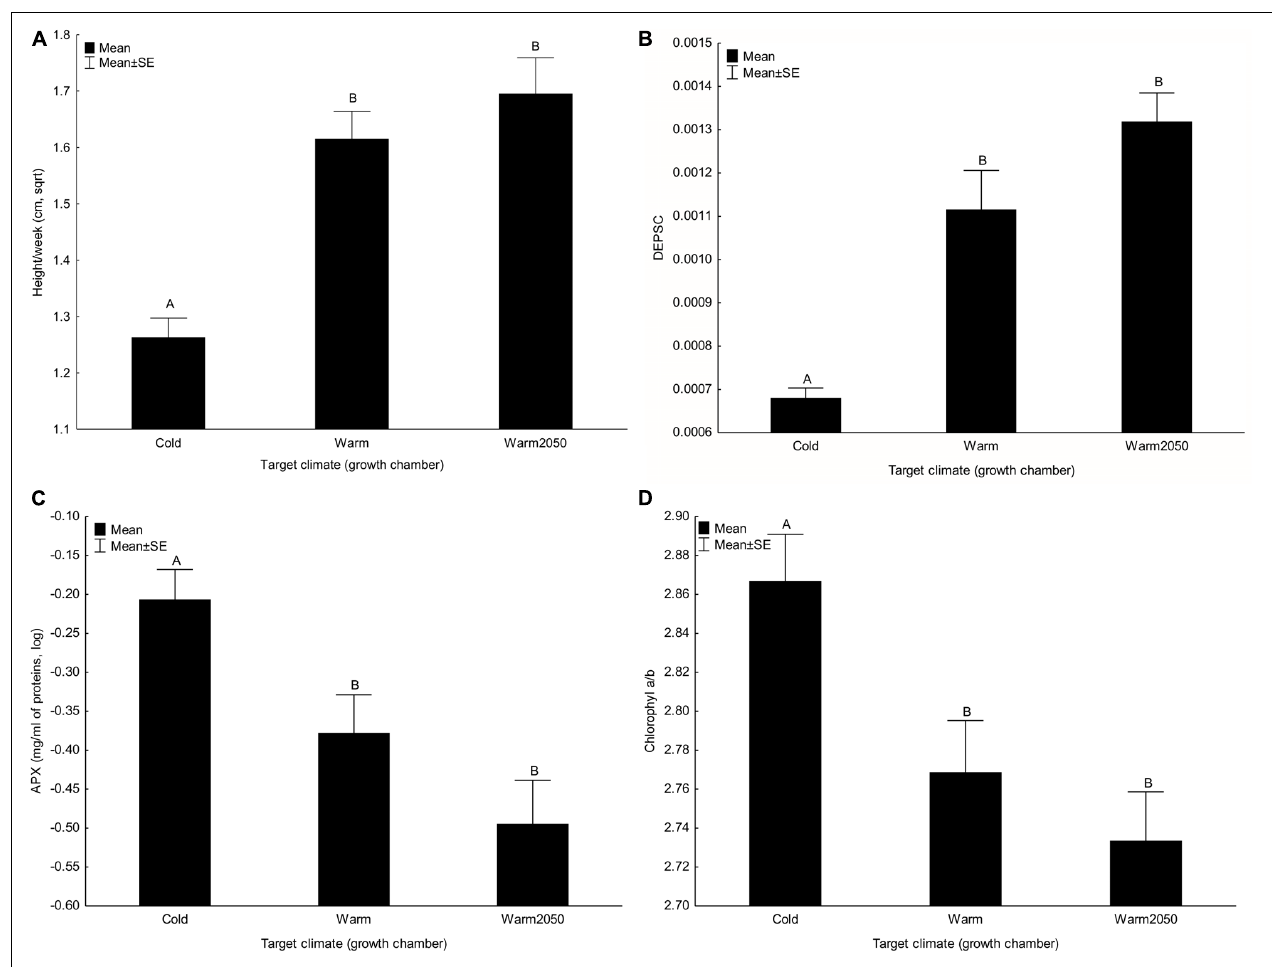
FIGURE 2 | Effect of target climate (growth chamber) on (A) height increase per week, (B) DEPSC, (C) L-ascorbate peroxidase and (D) chlorophyll a/b . Columns sharing the same letter are not significantly different from each other ( p >